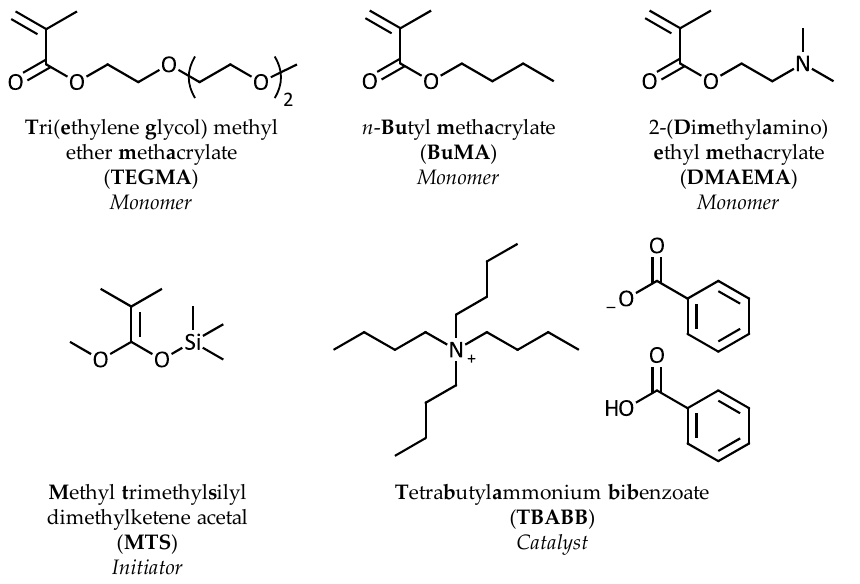
Figure 1. Chemical structures of the monomers, the initiator, and the catalyst.